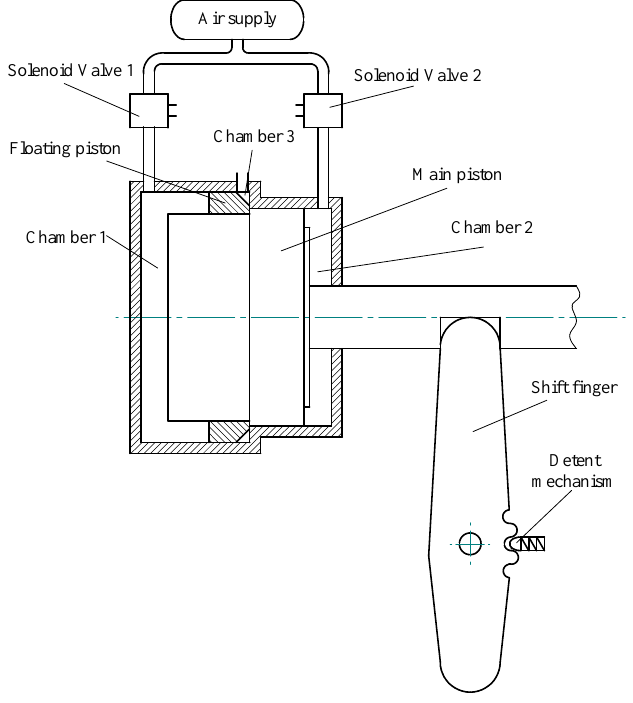
Figure 1. Simplified layout of the gearbox